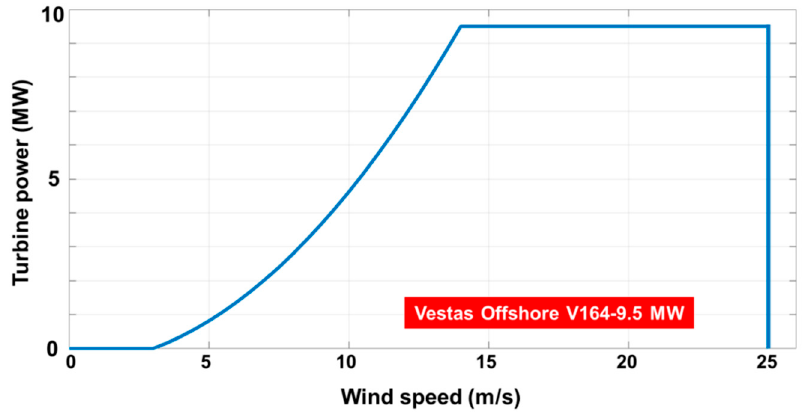
Figure 3. Power curve of the Vestas Offshore V164-9.5 MW wind turbine based on the information provided in Yue et al. [37].